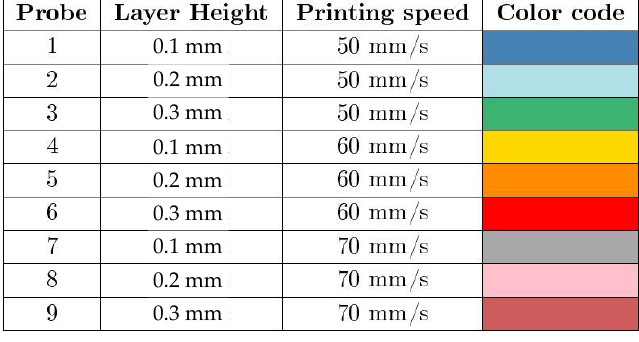
Figure 4. Parameters and color code in calibration probes.